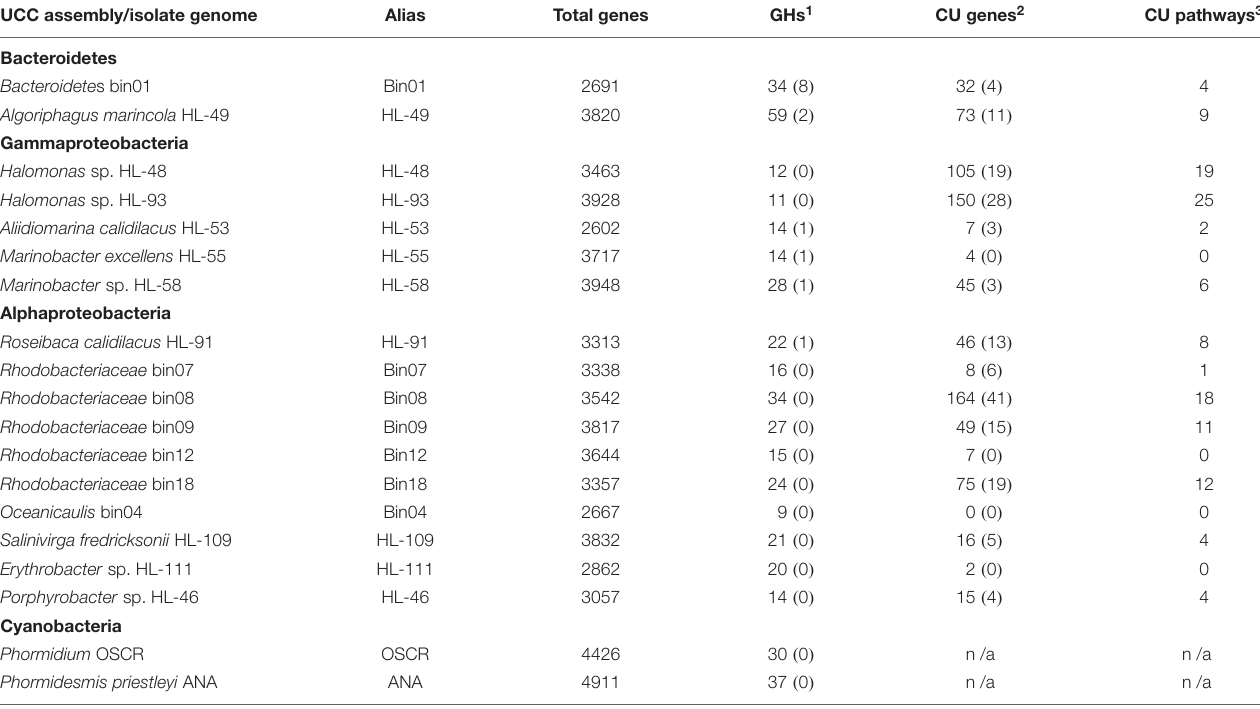
TABLE 1 | Genomic properties and overview of carbohydrate utilization capabilities of analyzed unicyanobacterial consortia (UCC)